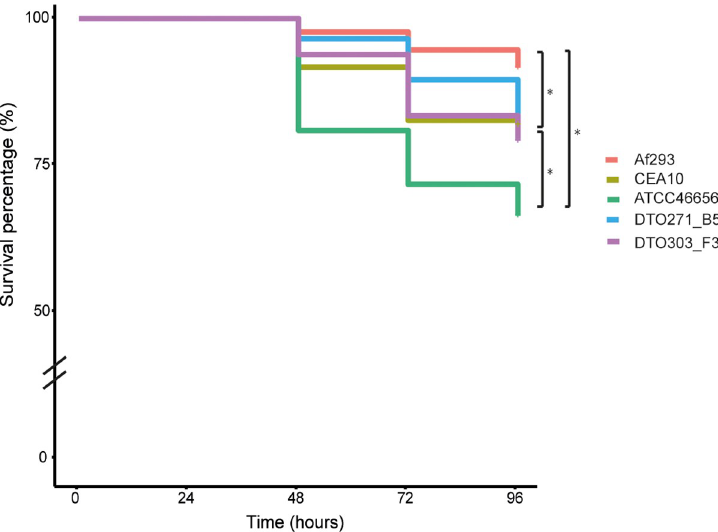
Fig 10. Kaplan-Meier survival plot of the zebrafish embryos injected with 100 conidia of different A . fumigatus isolates. Each line consists of three biological replicates. � indicates a statistical difference, based on a non-parametric log rank test with a p-value �